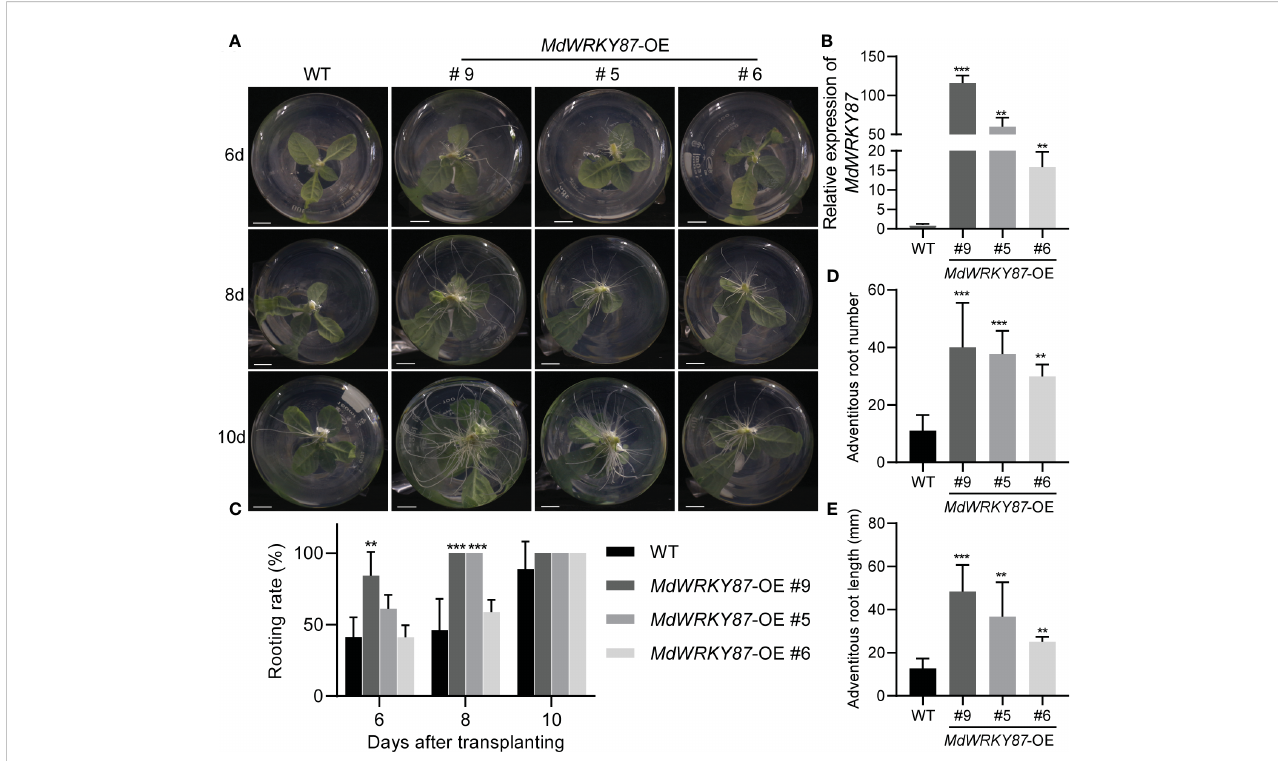
FIGURE 3 MdWRKY87 accelerates adventitious root formation in transgenic tobacco ( N. tabacum ) plants. (A) Phenotypes of adventitious roots in wild-type (WT) and independent transgenic lines ( MdWRKY87- OE9, MdWRKY87- OE5, and MdWRKY87- OE6) in the absence of auxin at 6, 8 and 10 days after transplanting into hormone-free MS medium. (B) qRT-PCR analysis of MdWRKY87 expression in WT and MdWRKY87- OE lines. (C) Adventitious rooting percentage of wild-type (WT) and independent transgenic lines at 6, 8 and 10 days after transplanting into hormone-free MS medium. (D, E) Number (D) and length (E) of adventitious roots at 10 days after transplanting into hormone-free MS medium. The mean values ± SD are shown for three biological replicates. Asterisks indicate signi fi cant differences between WT and each transgenic lines by Student ’ s t -test (** P < 0.01; *** P <